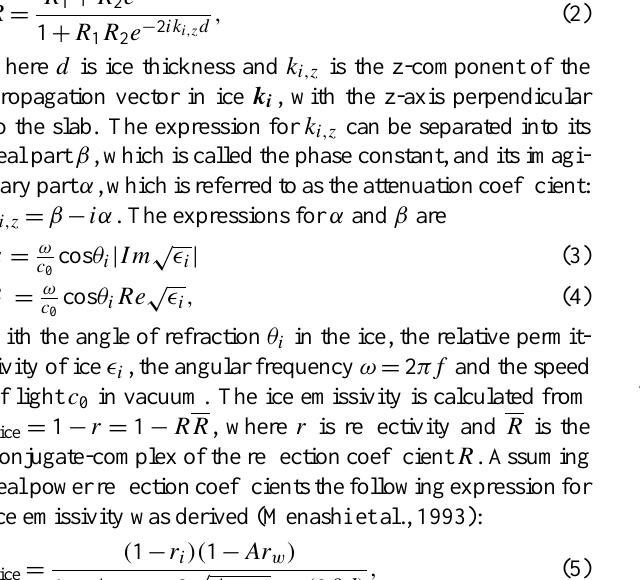
Table 1. Coefficients for the calculation of the sea-ice dielectric constant (Hallikainen and Winebrenner, 1992). The 1.4GHz coef- ficients are linearly interpolated.